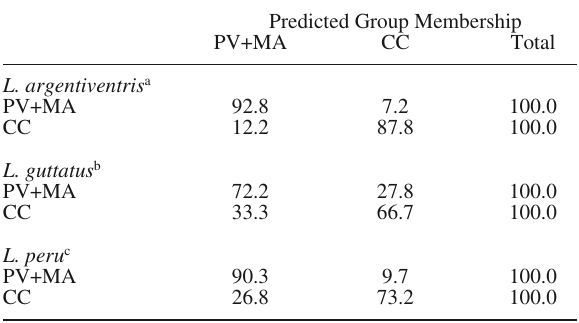
Table 5. – Discriminant analysis of scale form for the two geo- graphic variants (PV, Puerto Vallarta; MA, Manzanillo; and CC, Caleta de Campos) by species. The percentage of classification results by geographic variant is shown. Classification results (%) for total cross-validated predicted geographic variant membership.